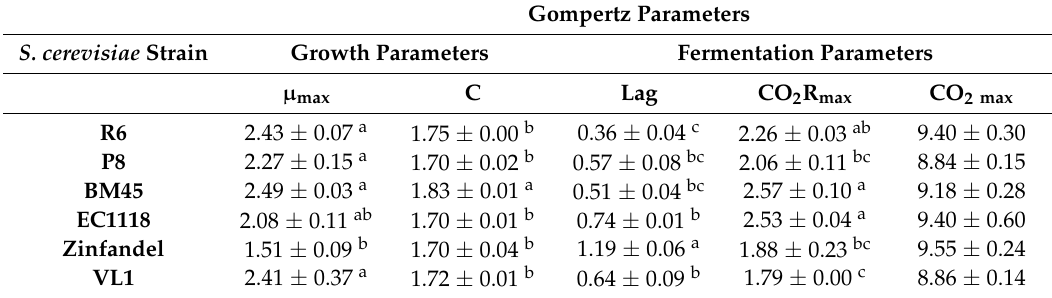
Table 1. Growth and fermentation parameters obtained by fitting to Gompertz’s equation the yeast cell counts and % CO 2 determined during alcoholic fermentation carried out in synthetic must by different S. cerevisiae strains. ( µ max is the maximum specific growth rate; C = increase in log count from initial cell concentrations to maximum yeast population; Lag = time from the beginning of fermentation